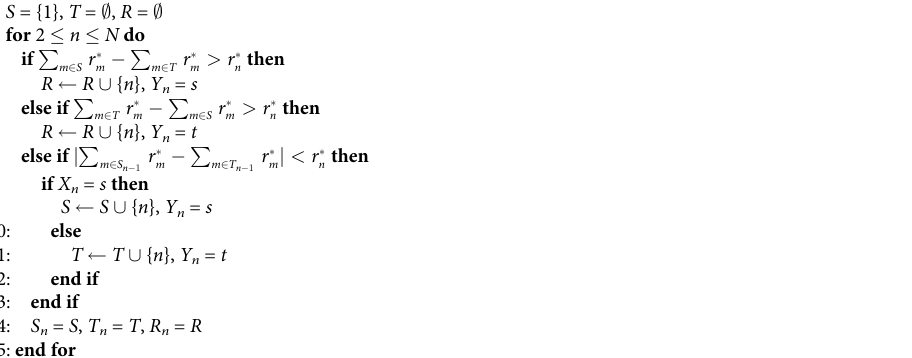
, and binary-choice alternatives, s and t . ϕ is n